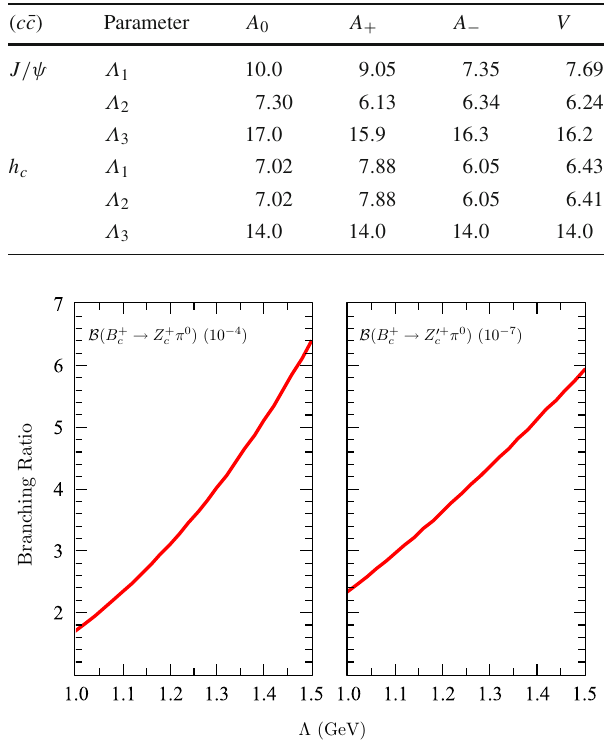
Fig. 2 Branching ratios of B c → Z c π (right panel) in unit of 10 − 4 and B c → Z (cid:5) c π (left panel) in unit of 10 − 7 depending on parameter Λ